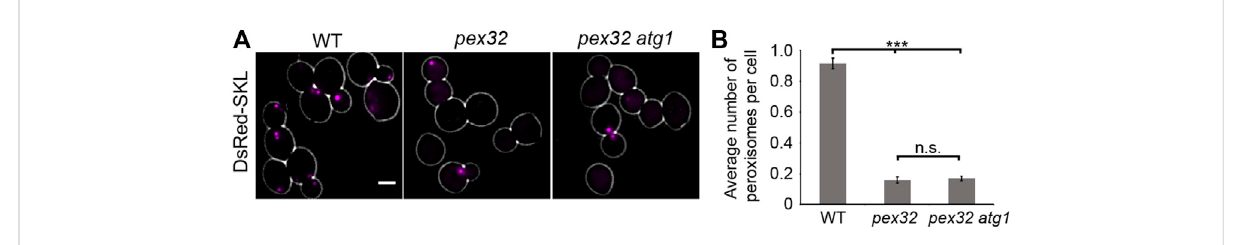
Reduced peroxisome abundance in pex32 cells is not caused by autophagy. (A) FM images of DsRed-SKL produced in WT, pex32, and pex32 atg1 cells grown on glucose for 4 h. Scale bar: 2 μ m. (B) Quanti fi cation of the average number of peroxisome per cell in indicated strains.